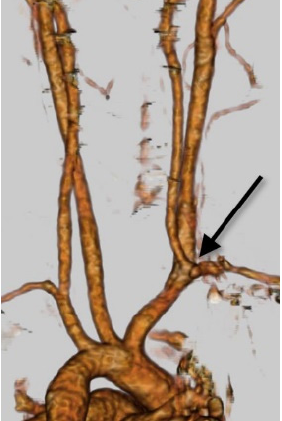
Figure 6. Right VA originating from the BCT. Right posterior oblique view on VR-CT angiography shows the RVA arising from the BCT (black long arrow). The SYNAPSE VINCENT software 6.3 (Fujifilm Holdings Corp., Tokyo, Japan) was used to obtain the VR image.